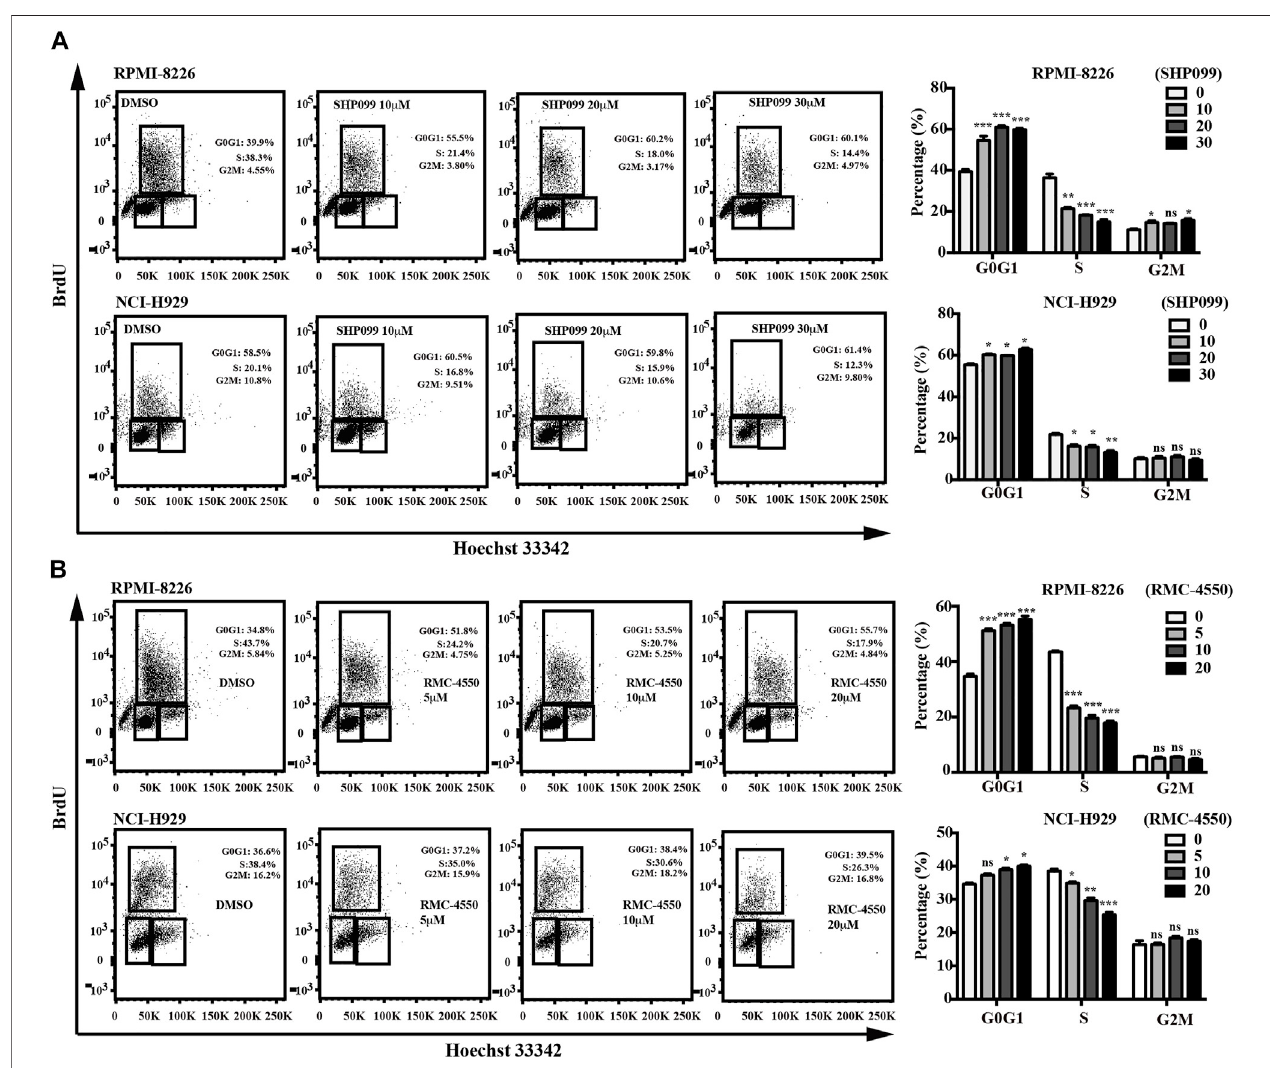
FIGURE 3 | SHP2 inhibitors promote cell-cycle arrest. RPMI-8226 and NCI-H929 cells were treated with different concentrations of SHP099 (A) and RMC-4550 (B) for48 h,andcell-cycleanalysisbyBrdU/Hoechst33342stainingofMMcellswasanalyzedby fl owcytometry.Dataarerepresentativeofthreeindividualexperiments with similar results and are represented as mean ± SD. * p < 0.05, ** p < 0.01, *** p < 0.001, and nonsigni fi cant ( p > 0.05).